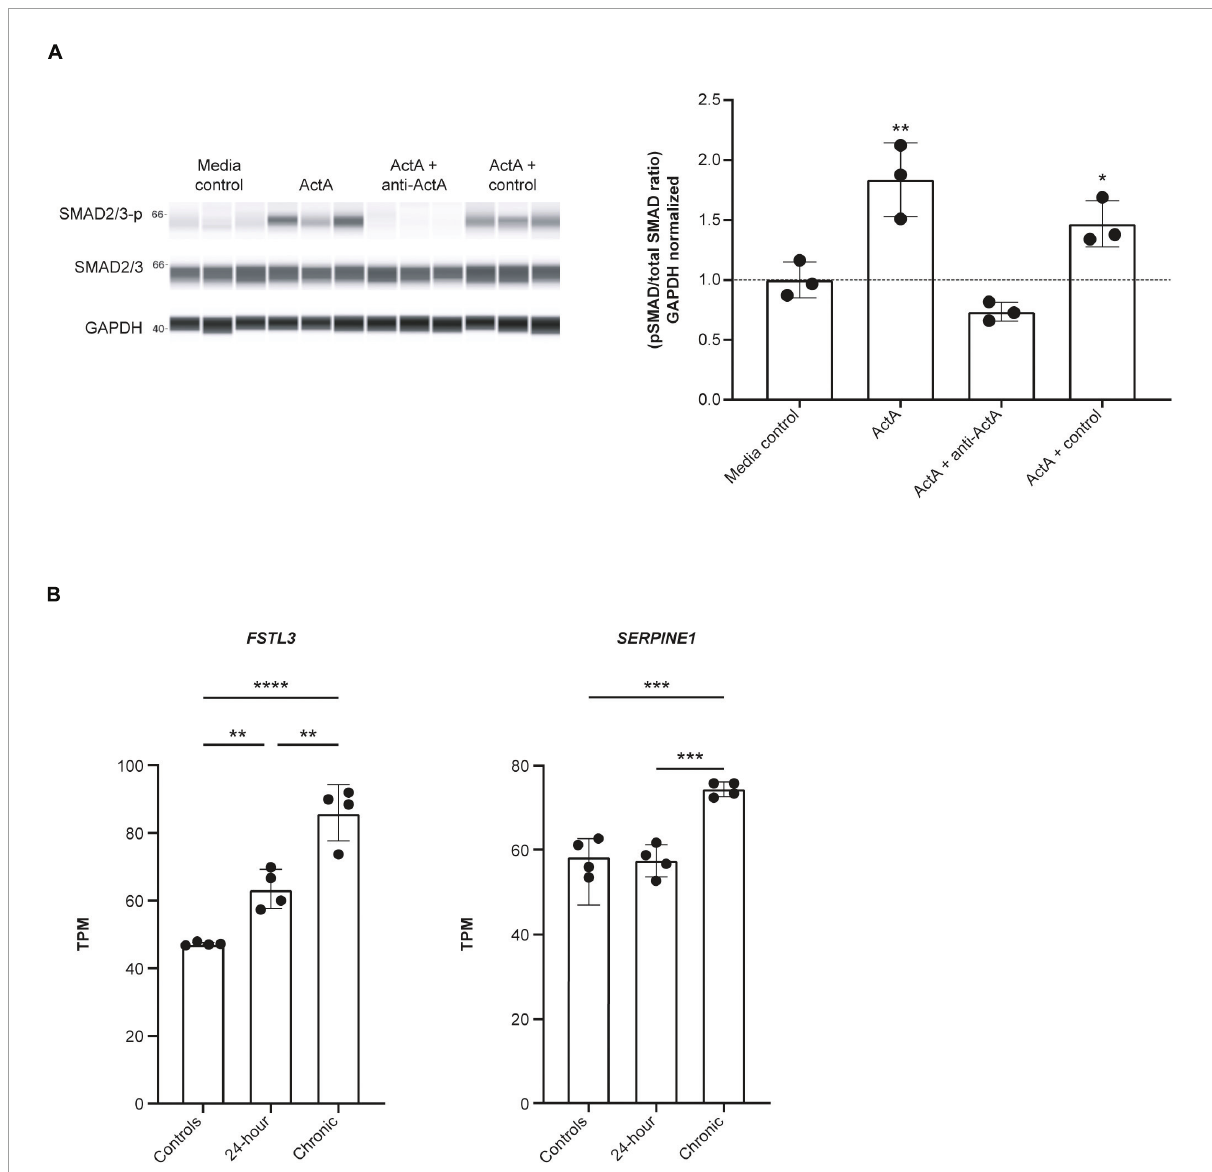
FIGURE2 Activin A induces SMAD3 phosphorylation and downstream signaling in hiPSC-CMs. (A) Automated western blot data for the effect of Activin A plus anti–Activin A antibody or an isotype control on SMAD2/3 phosphorylation. (B) RNA sequencing data for expression of FSTL3 , and SERPINE1 (PAI1) expression following exposure to 1 nM Activin A. One-way ANOVA was used to determine significance. * P < 0.05, ** P < 0.01, *** P < 0.001, **** P < 0.0001. ActA, Activin A; hiPSC-CM, human-induced pluripotent stem cell-derived cardiomyocyte; GAPDH, glyceraldehyde 3-phosphate dehydrogenase; TPM, transcripts per